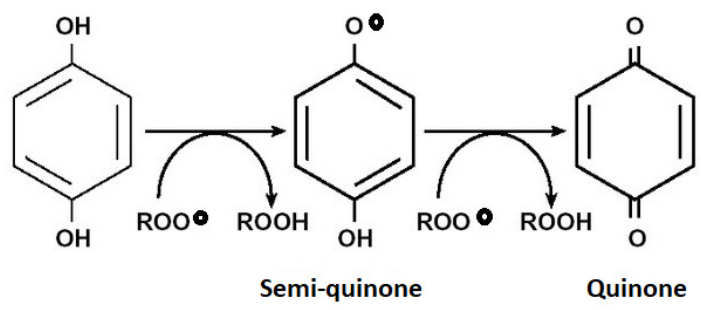
Figure 7. General oxidation reaction mechanism of a phenolic compound.